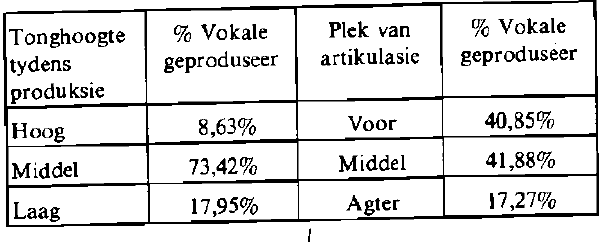
Tabel 11: Voorkoms van die vokale wat geproduseer is